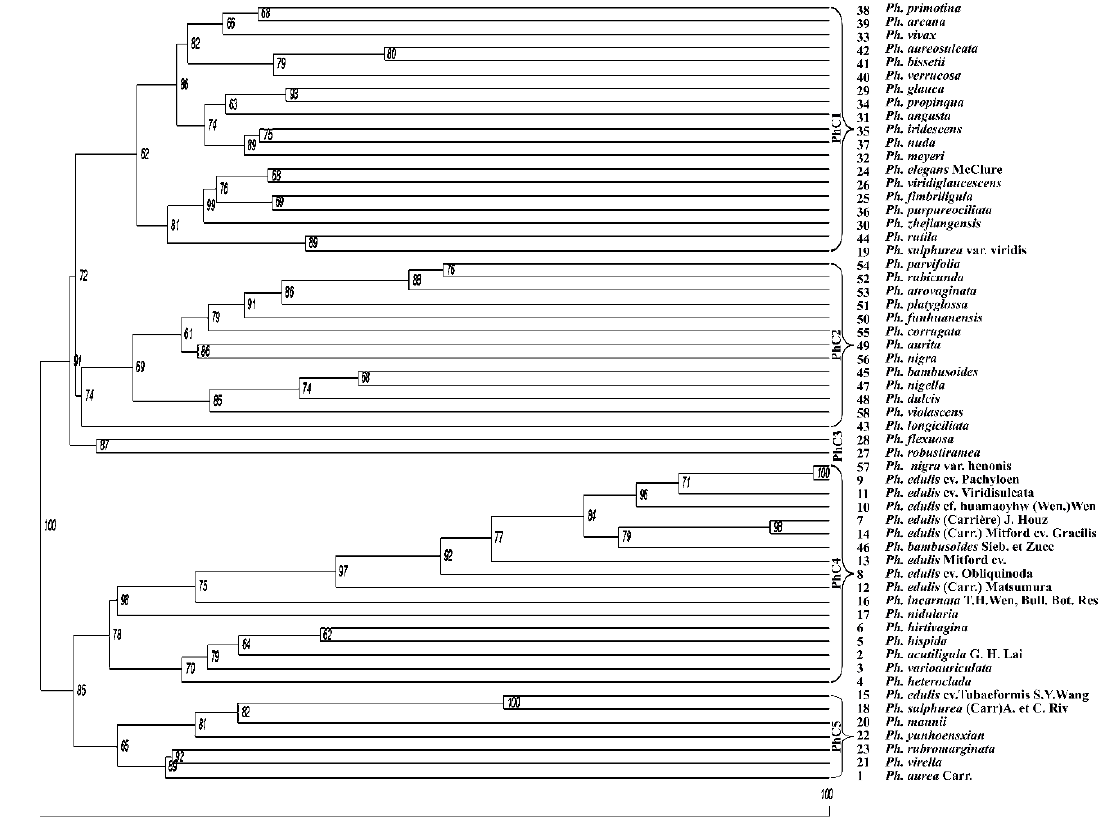
Figure 4. Dendrogram using the genetic distance matrix based on Jaccard’s similarity coefficient obtained by hierarchical clustering analysis. The unweighted pair-group method with arithmetic average (UPGMA) with the bootstrap analysis showing the genetic relationship of 58 Phyllostachys species (Asian bamboo) based on inter-retrotransposon amplified polymorphism (IRAP) markers. The numbers present inside the clusters represent the bootstrap values. The numbers in bold represent different Asian bamboo species as defined in Table 1.